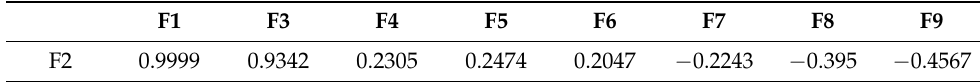
Table 8. The Pearson correlation coefficients between F2 and the other eight features.